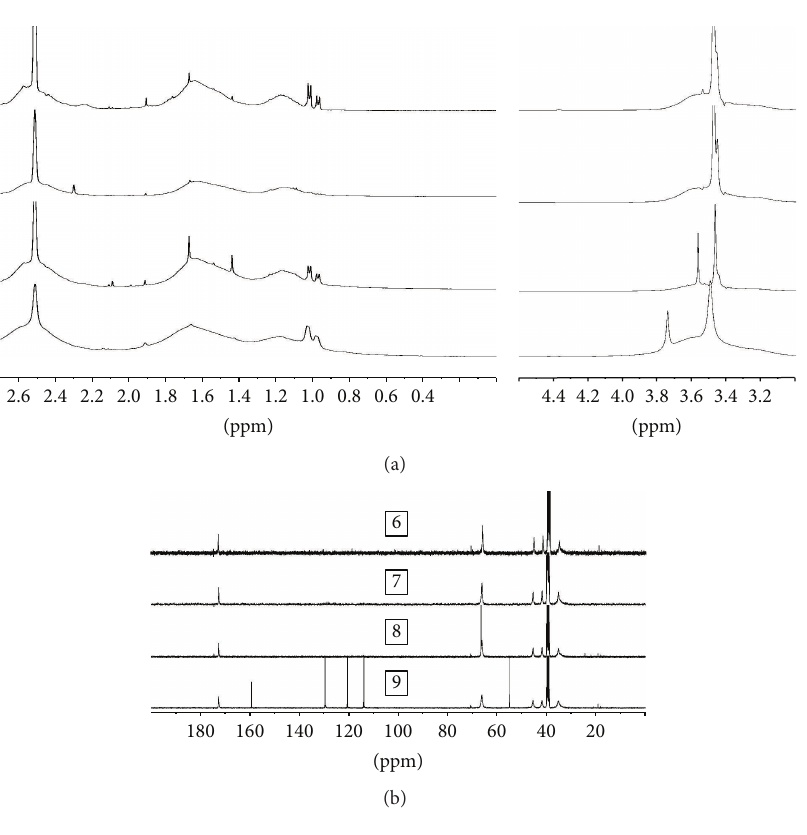
Figure 4: NMR spectra (solvent DMSO) for poly(NAM) synthesized in different solvents: 6 in anisole, 7 in 1,4-dioxane, 8 in toluene, and 9 in THF: (a) 1 H-NMR; (b) 13